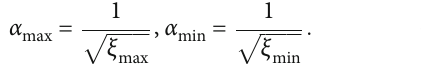
= 9 , 11, and 12.50mm; vh